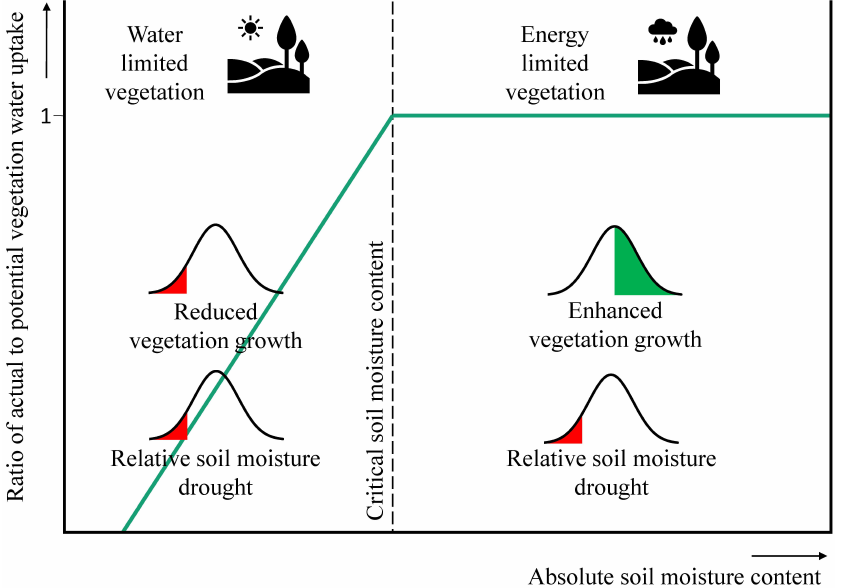
Figure 1. The ambiguity of agricultural drought. Normalised agricultural drought indices across a range of climates or mean soil moisture (SM) contents can show contrasting signs due to the non- linearity between the soil moisture and vegetation water uptake. In water-limited (arid) climates, a normalised soil moisture drought (i.e., negative SM anomaly) will generally be accompanied by a drought in the vegetation indices (i.e., a negative growth anomaly). In humid climates, where the soil moisture generally does not limit the evapotranspiration and plant functioning, normalised soil moisture indices might indicate drought, whereas vegetation indices might show positive anomalies, as long as the soil moisture is above the absolute critical soil moisture